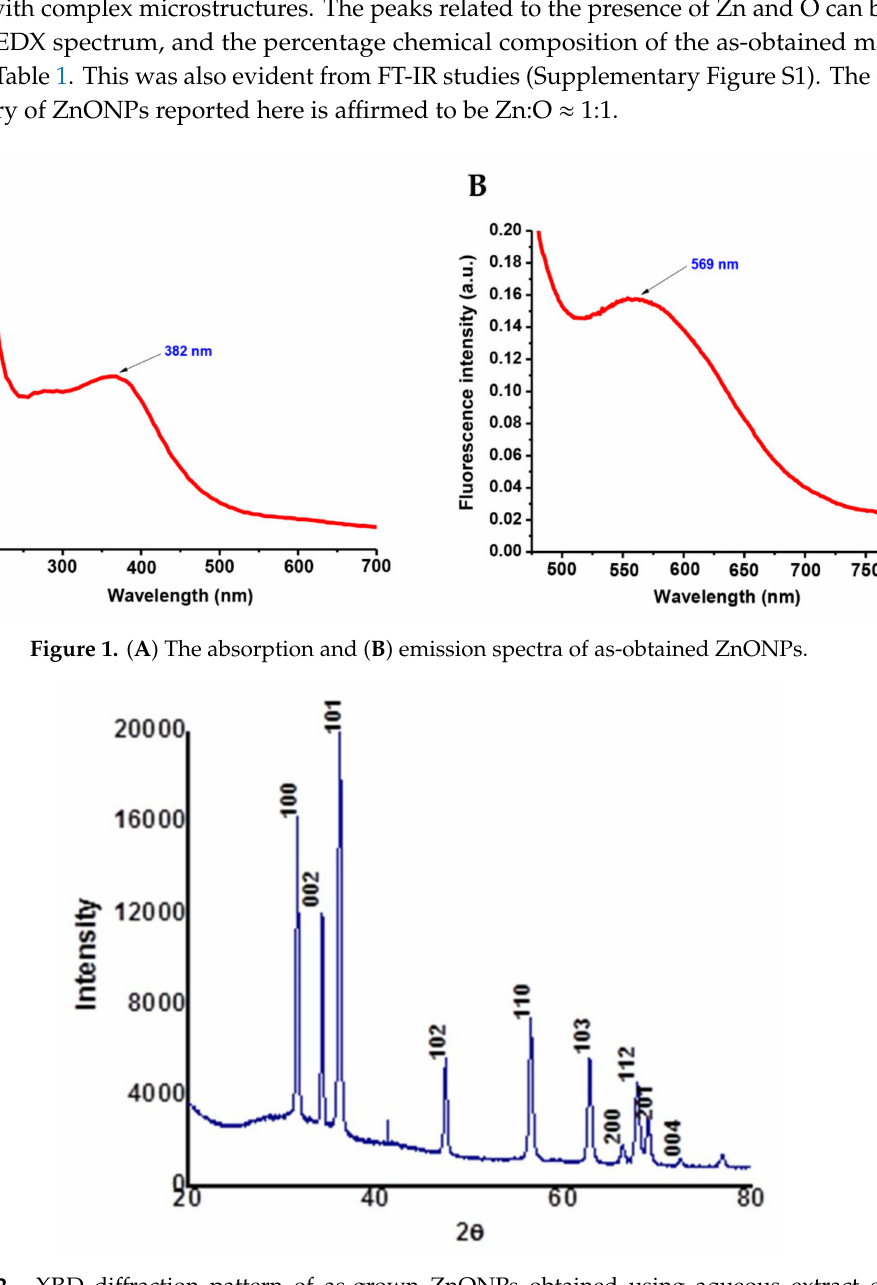
Figure 2. XRD di ff raction pattern of as-grown ZnONPs obtained using aqueous extract of C. auriculata